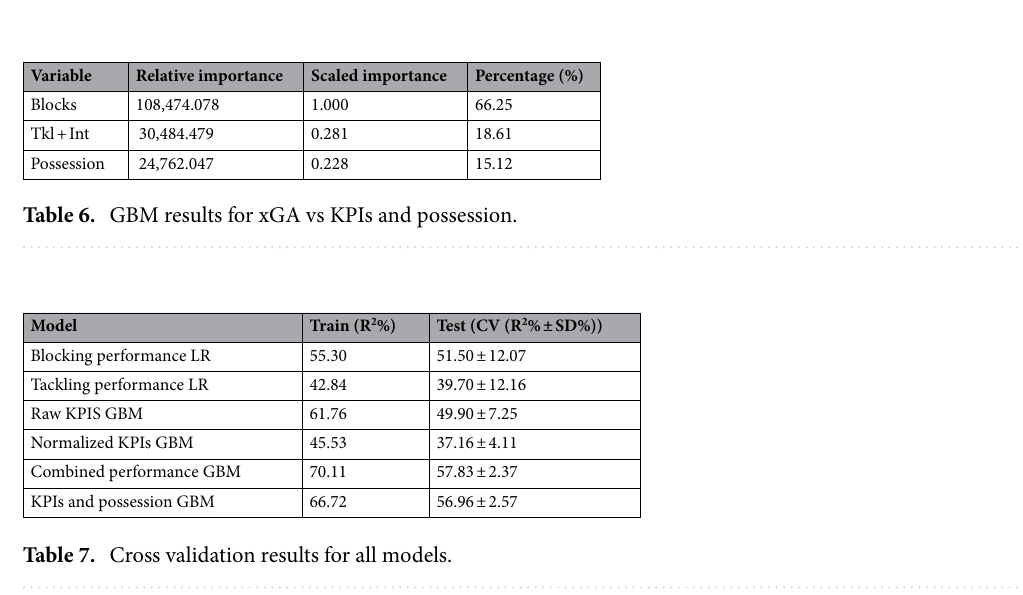
Table 5. GBM results for xGA vs combined KPIs.